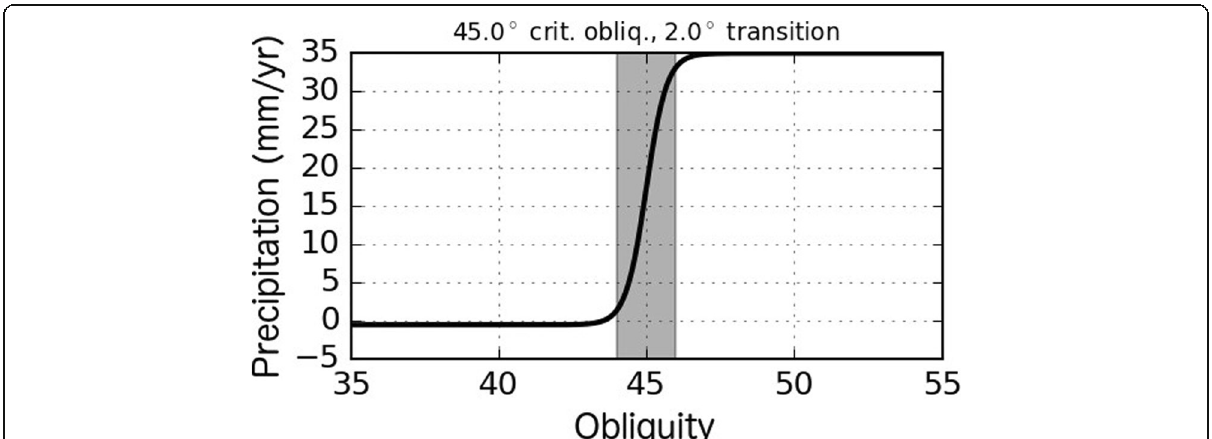
Fig. 5 Obliquity-dependent precipitation rates assumed for the accumulation zone. The model assumes precipitation follows a logistic curve with the transition from ablation to precipitation (35 mm/year) occurring over a 2 ° window in obliquity (shaded region) centered at 45 ° . The rate of ablation varies with temperature (dependent on obliquity and surface slope, see Figs. 8 and 9)